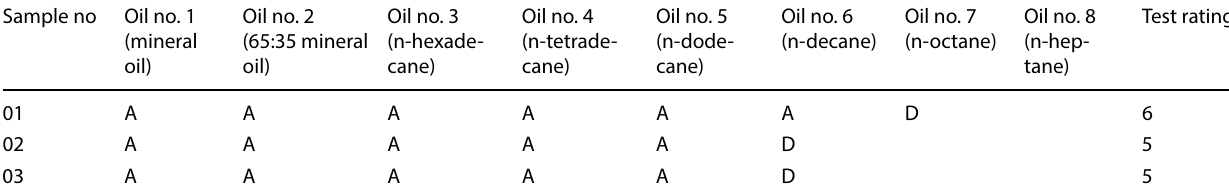
Table 9 Hydrocarbon resistance test for HDTMS-treated nonwoven cotton fabric